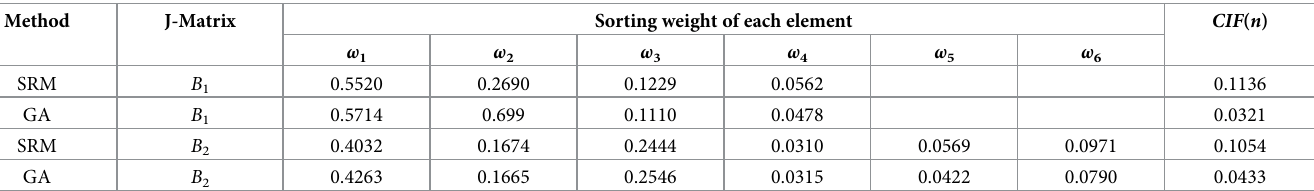
Table 1. The comparison of the weights. Method J-Matrix Sorting weight of each